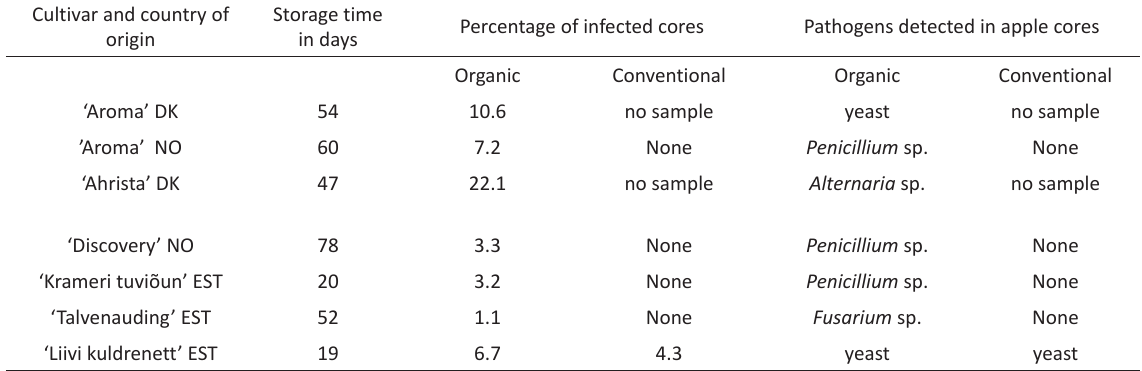
Table 2. The percentage of organic and conventional apples with visual symptoms of pathogen infections in cores before juice processing in 2016 and pathogens determined 7 days after plating spores onto PDA agar Cultivar and country of